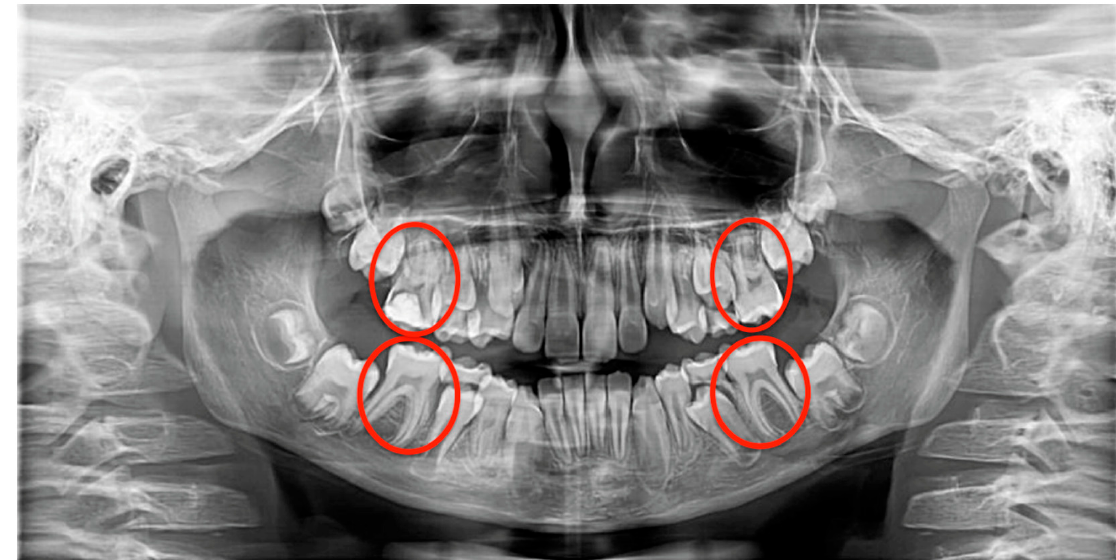
Figure 1. Panoramic radiograph with the first permanent molars highlighted.